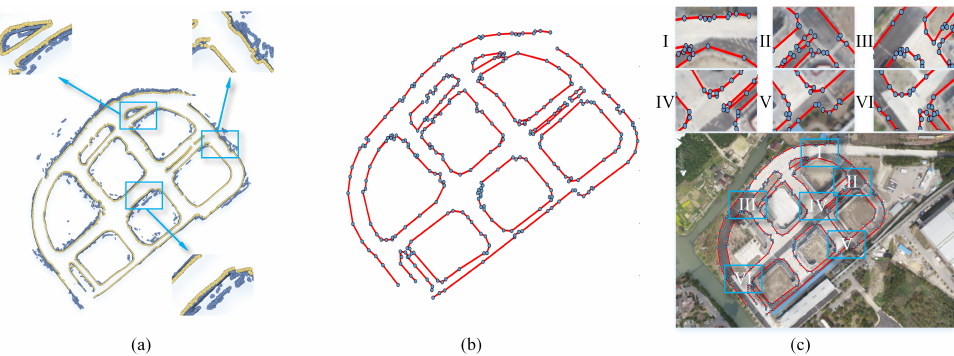
Figure 13. Experimental results of the proposed method on a test field. ( a ) resulting road boundary points (blue) and innermost road boundary points (yellow). ( b ) resulting vectorized map obtained by the proposed method. ( c ) the superposition of the vectorized map obtained by the proposed method and the aerial image of mapped area.